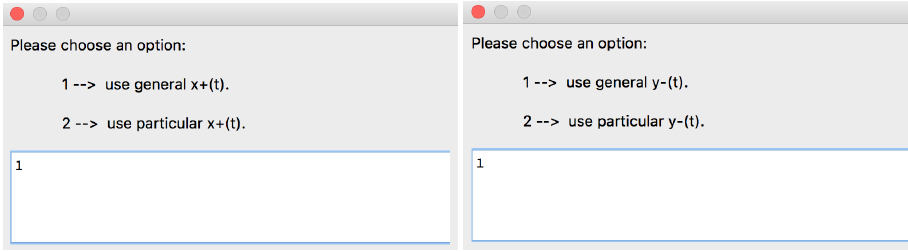
Figure 8. Part of the structure of the [SInt] algorithm corresponding to the input of x + and y − . The [SInt] algorithm gives the singular integrals presented in Figure 9.